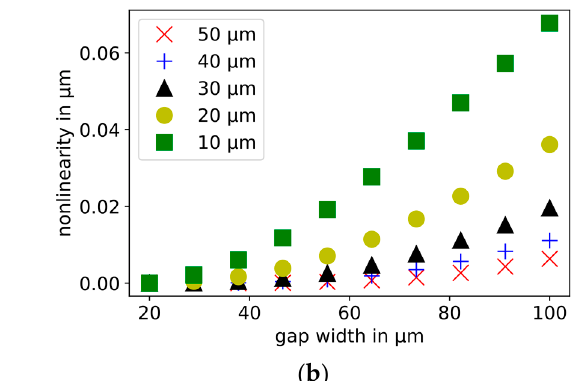
Figure 13. Influence of the starting distance between probe and target on the influence of the width of the dielectric gap on ( a ) the normalized slope error and ( b ) the normalized nonlinearity. The larger the starting distance, the faster the slope error increases and the slower the nonlinearity increases with the increasing dielectric gap width.